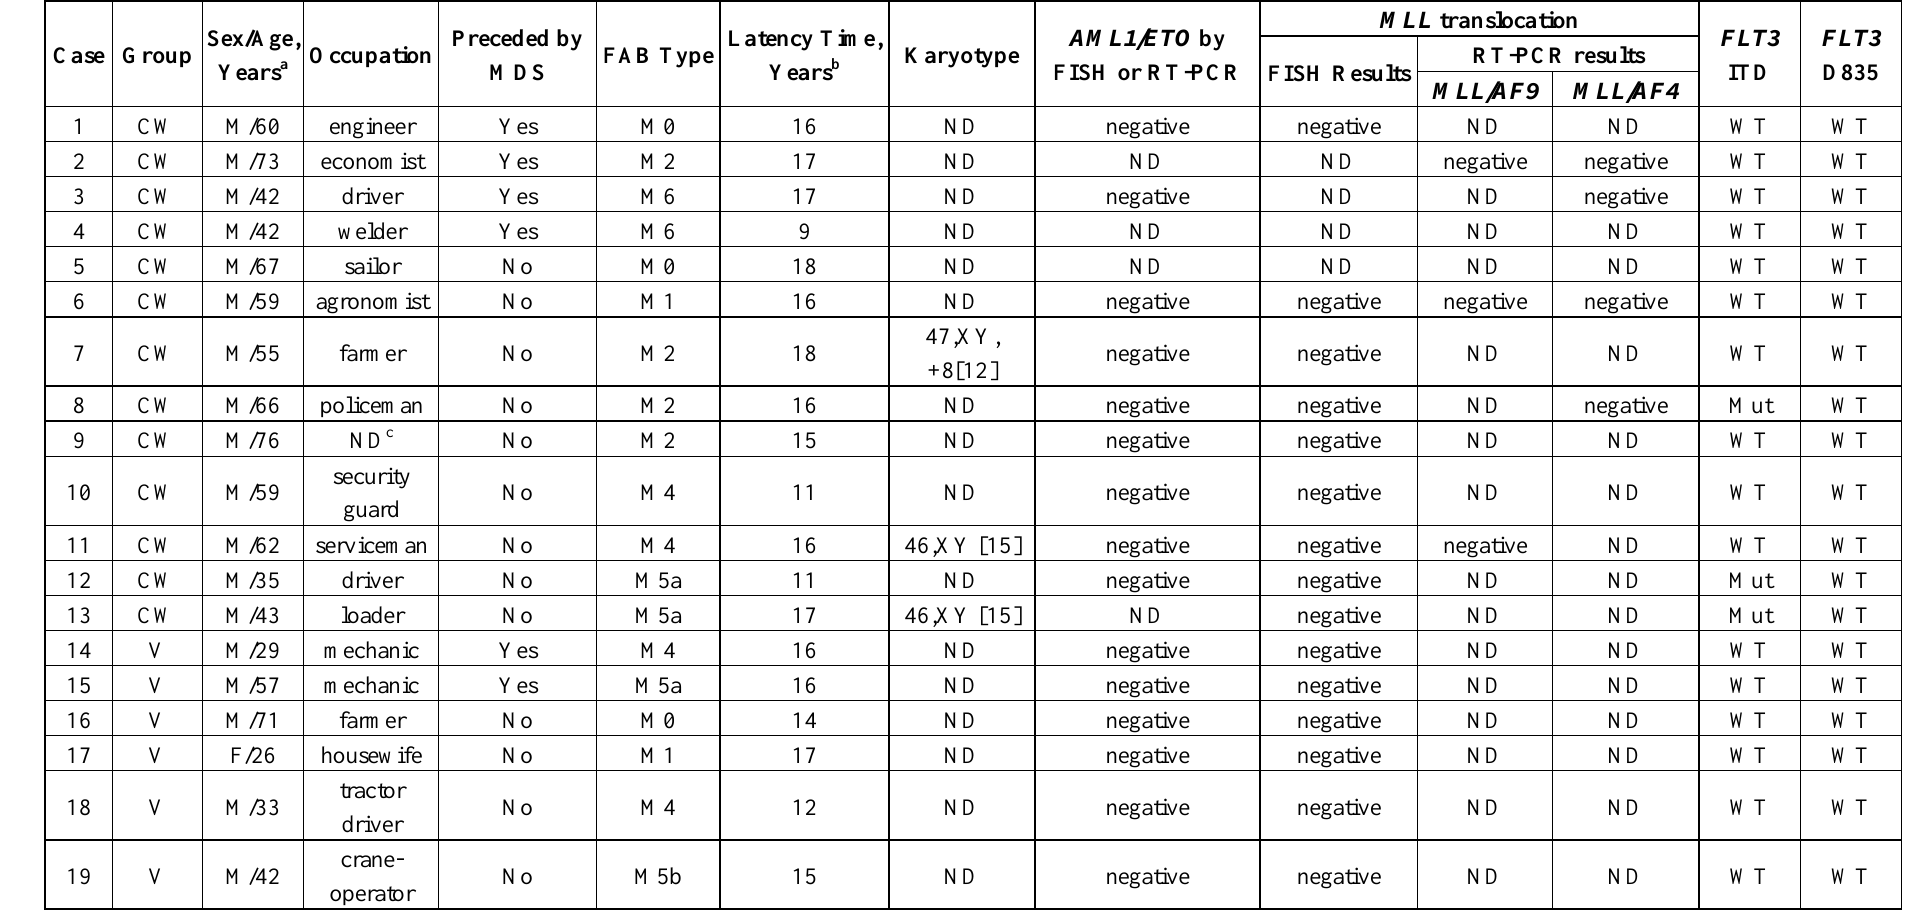
Table 2. Anamnestic, clinical, cytogenetic and molecular genetic information of radiation-associated AML patients. Sex/Age, Preceded by Case Group Occupation Years a